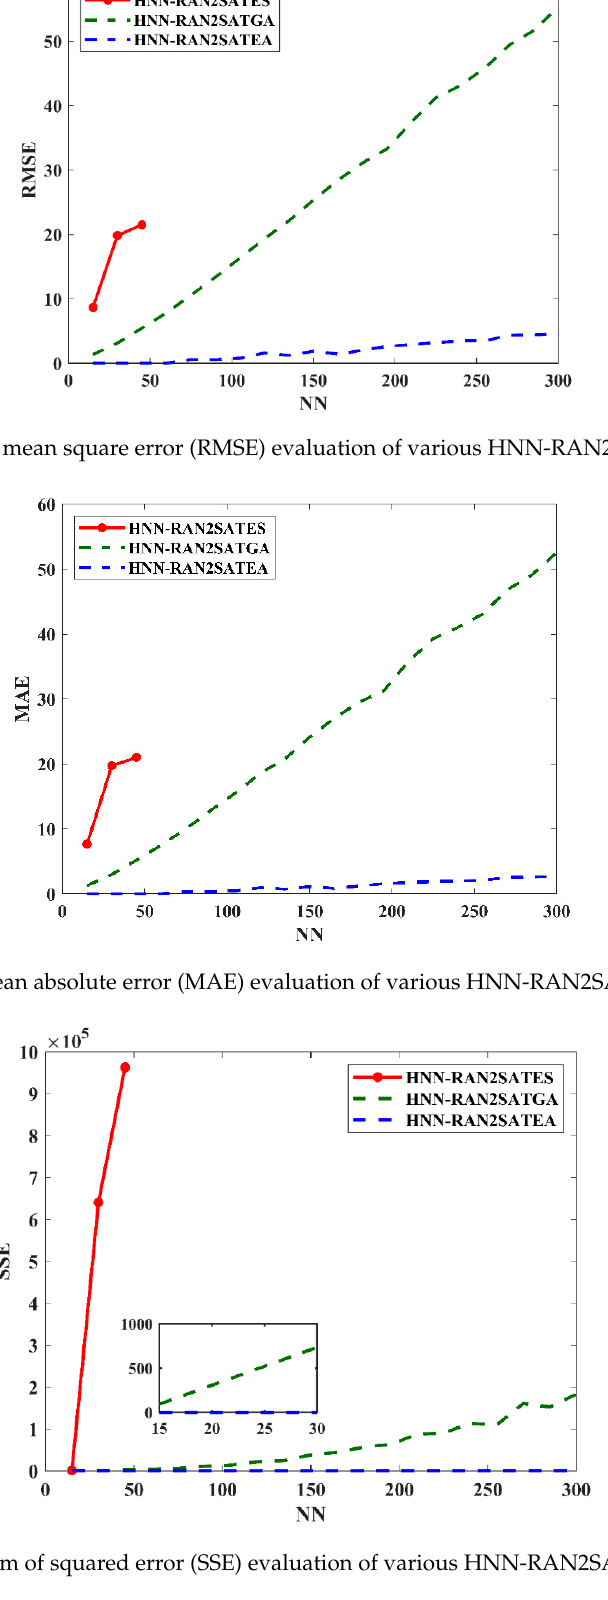
Figure 5. Mean absolute percentage error (MAPE) evaluation of various HNN-RAN2SAT models. 7. Conclusions Firstly, EA has been proposed as a learning algorithm during the learning phase of the first order and second order clauses of RAN2SAT. Thus, the capability of EA is determined by the systematic optimization layers, positive advertisement, negative advertisement, and the coalition operator, which successfully minimize the error evaluations towards the global solution. Secondly, we compared the effectiveness of EA in the learning phase with the existing algorithm, GA, and ES while manipulating the number of neurons. The findings showed that HNN-RAN2SATEA outperformed the other two models, HNN-RAN2SATES and HNN-RAN2SATGA, due to its effective learning mechanism, especially in partitioning the solution spaces to reduce complexity. The effective partitioning of the search space in EA allowed the searching process to be more accurate without undergoing intensive processes. It was found that HNN-RAN2SATES experienced neuron oscillations when NN ≥ 45 , indicating the weakness of ES as the learning mechanism. This work has successfully highlighted the capability of EA and RAN2SAT during the learning phase for generating more diversified interpretations that lead to global minimum solutions. Extending from our study, different classes of Hopfield Neural Networks can be adopted, such as Mutation Hopfield Neural